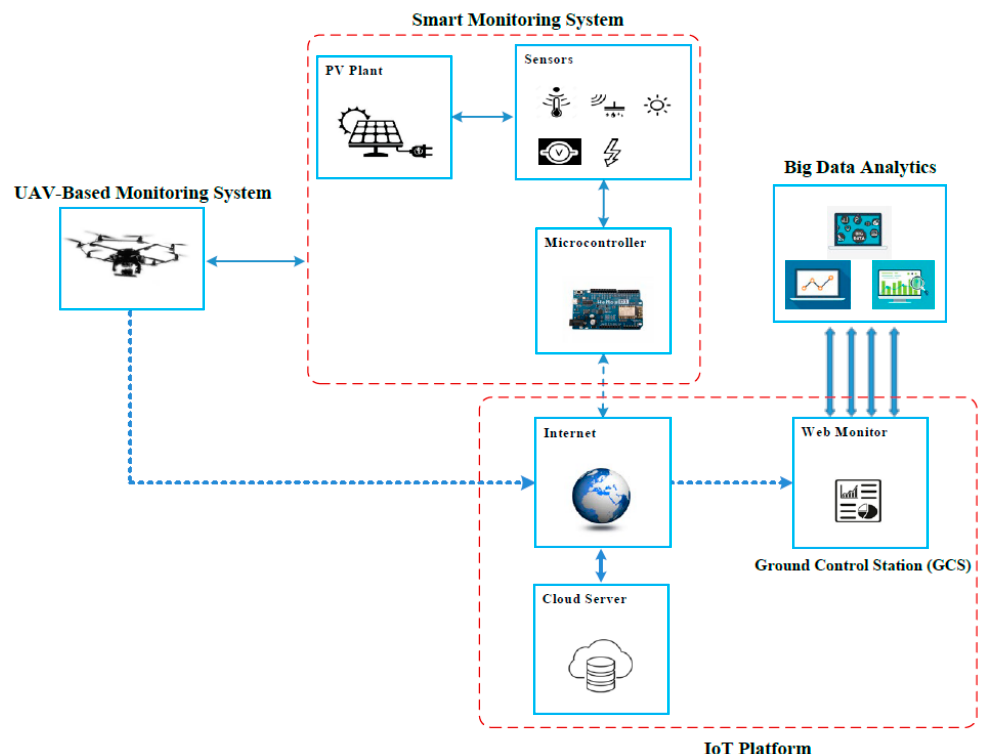
Figure 1. Concept scheme of autonomous monitoring and analysis of PV systems. Reprinted with permission from Ref. [9].